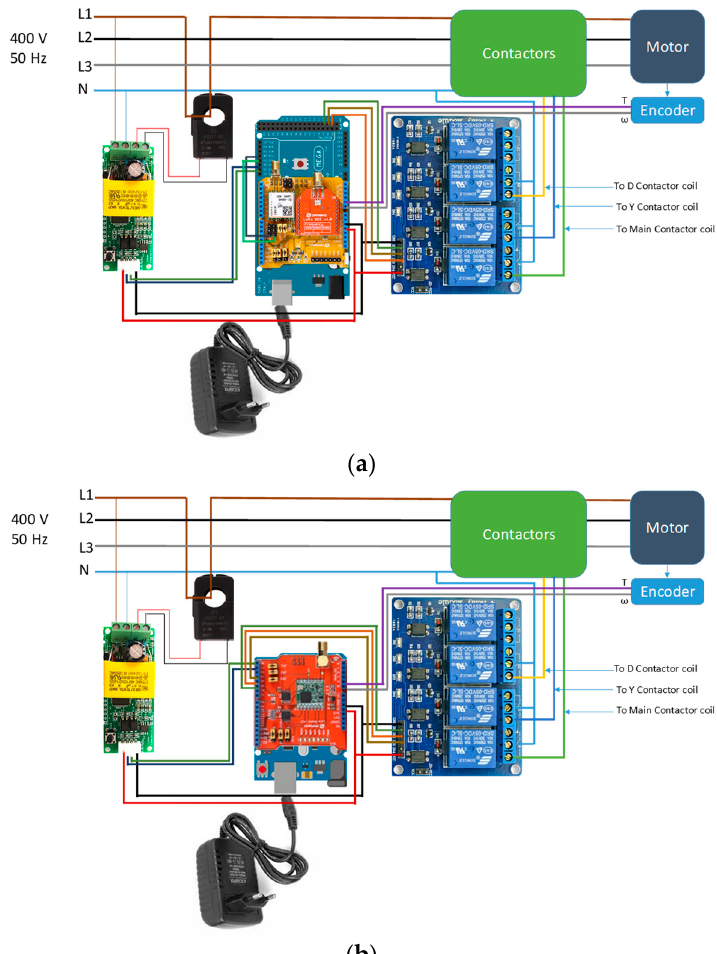
Figure 4. IMEMSL versions: ( a ) With GPS; ( b ) Without GPS.